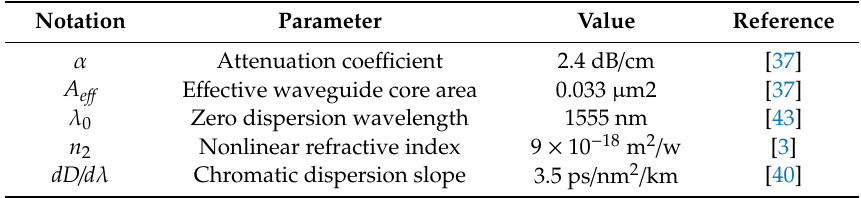
Table 3. Parameters used in FWM noise model.